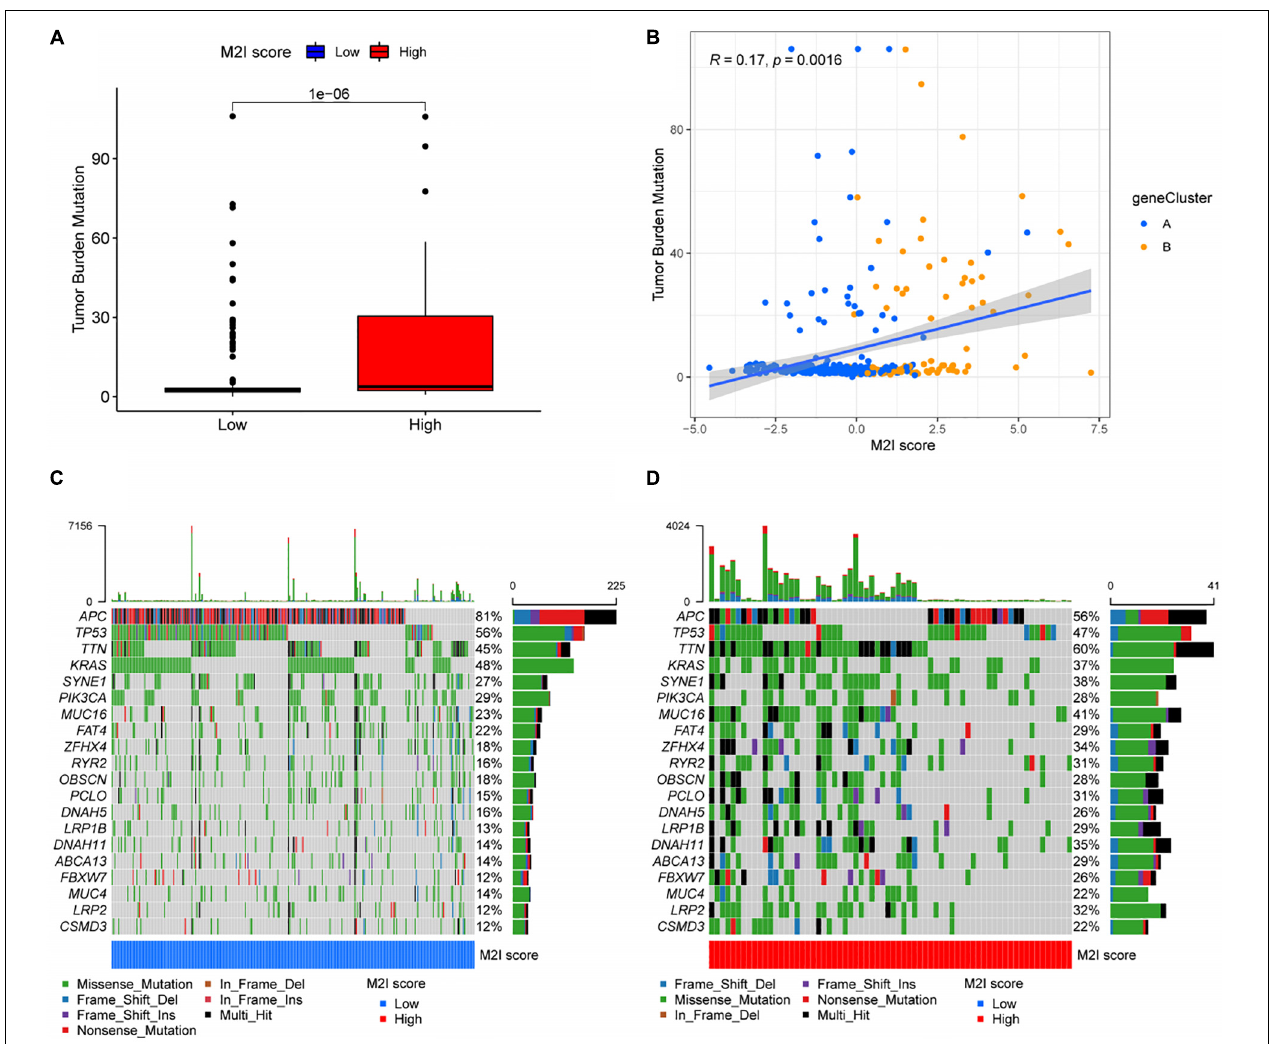
FIGURE 5 | Correlation between M2I Score and somatic variation. (A) TMB difference between high and low M2I score subgroups. (B) Correlation analysis between M2I score and mutation load. (C,D) oncoPrint of the top 20 genes with the highest mutation frequency in the subgroup of high and low M2I